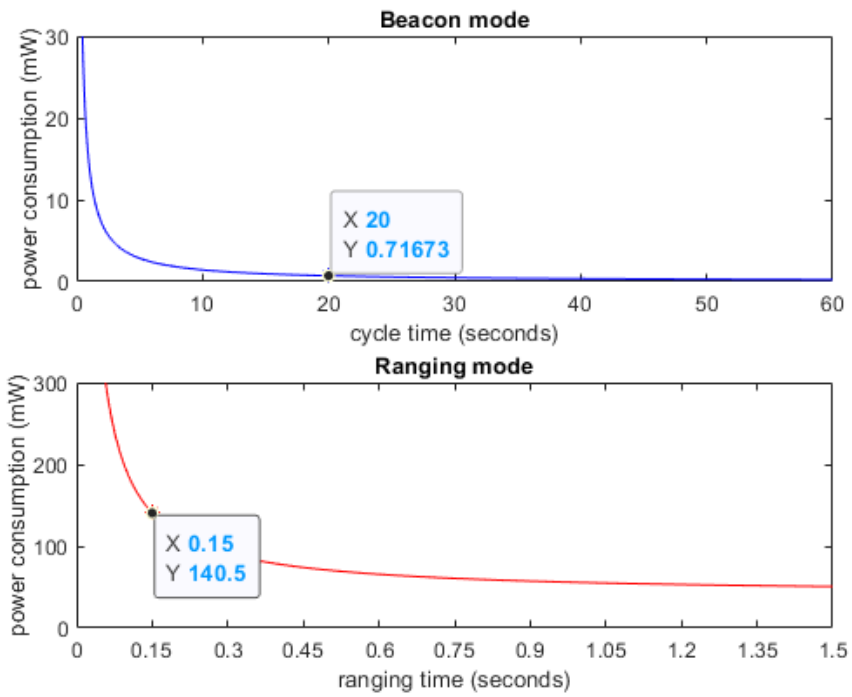
Figure 14. Anchor: average power consumption for the Beacon and the Ranging